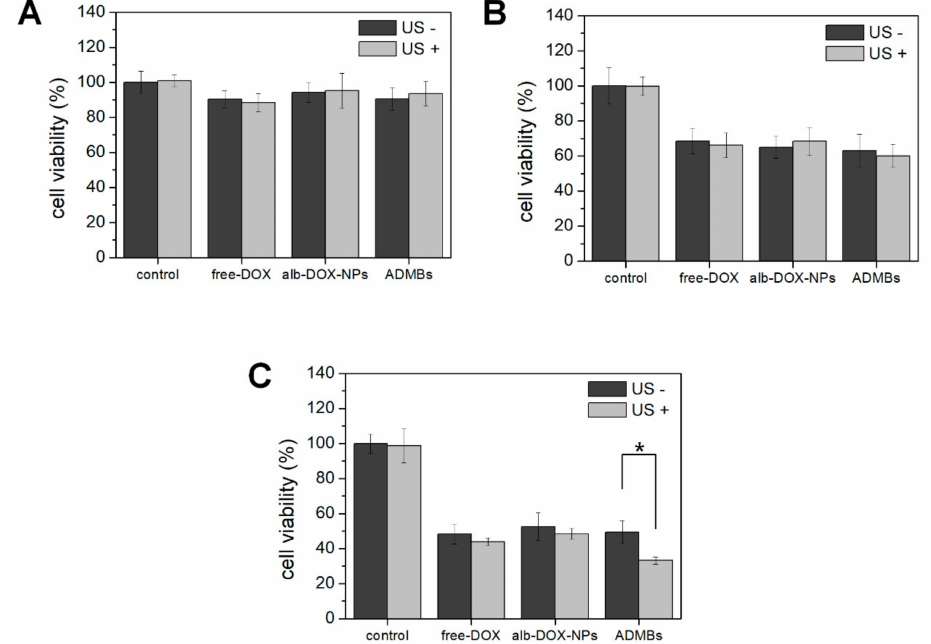
Figure 5. Cytotoxicity of doxorubicin (free-DOX) albumin-doxorubicin nanoparticle (alb-DOX-NPs) and ADMBs at ( a ) 24 h, ( b ) 48 h and ( c ) 72 h with (light gray) or without (dark gray) ultrasound exposure (* p <